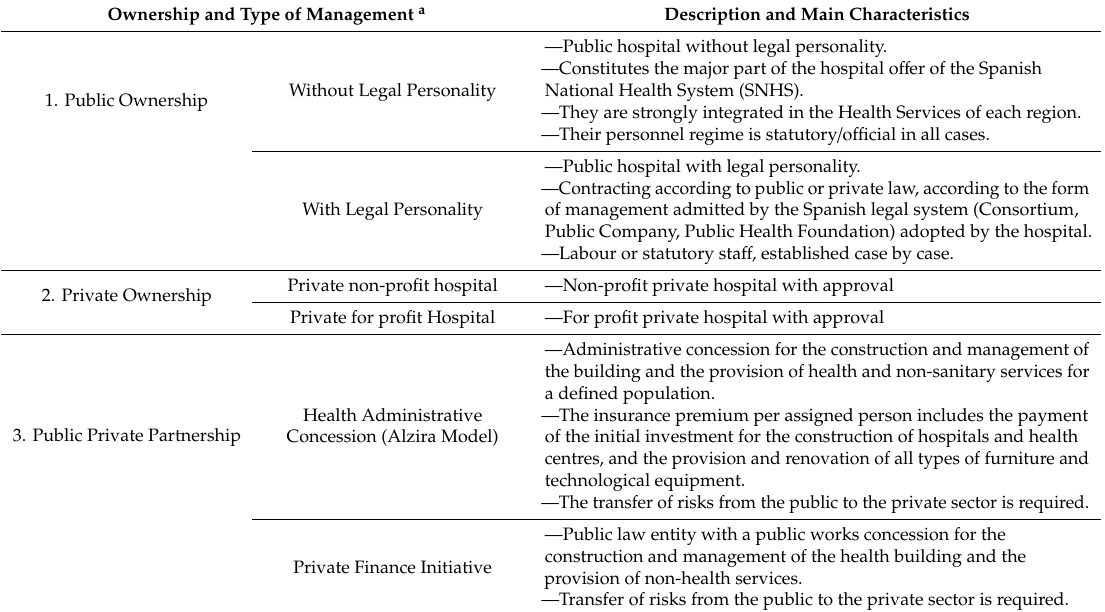
Table A1. Ownership and management of Spanish National Health System general hospitals.